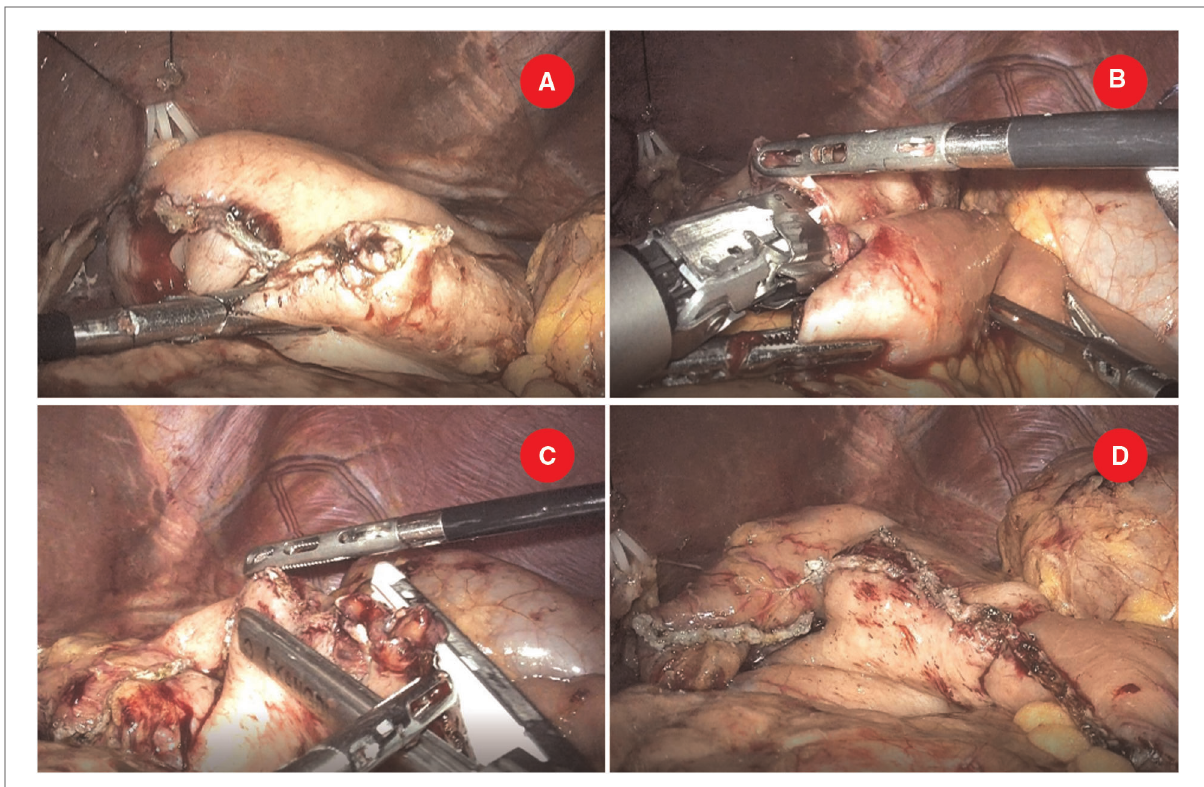
FIGURE 2 Gastrojejunostomy was performed intracorporeally. ( A ) Another small opening was made on the staple line of the greater curvature of the stomach stump. ( B ) A 60 mm endoscopic linear stapler cartridge was inserted to perform intracorporeal gastrojejunostomy. ( C ) Two 45-mm-long cartridges were employed to close the common entry of gastrojejunostomy. ( D ) The completion of the modi fi ed Roux-en-Y